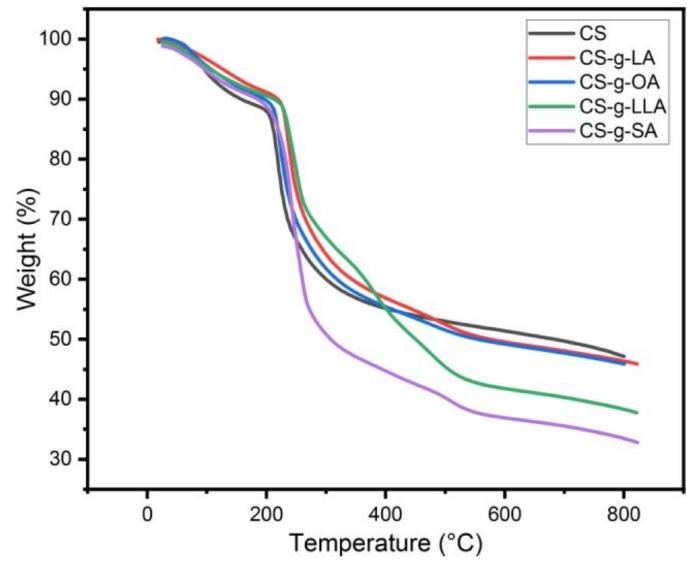
Figure 3. TGA comparison of CS and grafted CS–fatty acid amides.